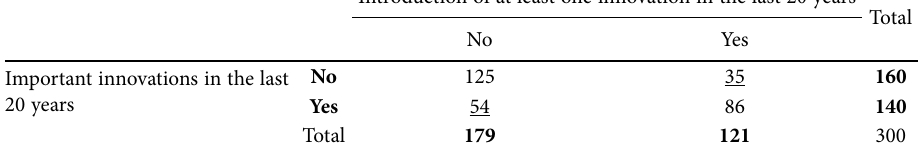
Table 3. Cross-tabulation of innovation introduction and consideration of important innovations in the last 20 years. Introduction of at least one innovation in the last 20 years